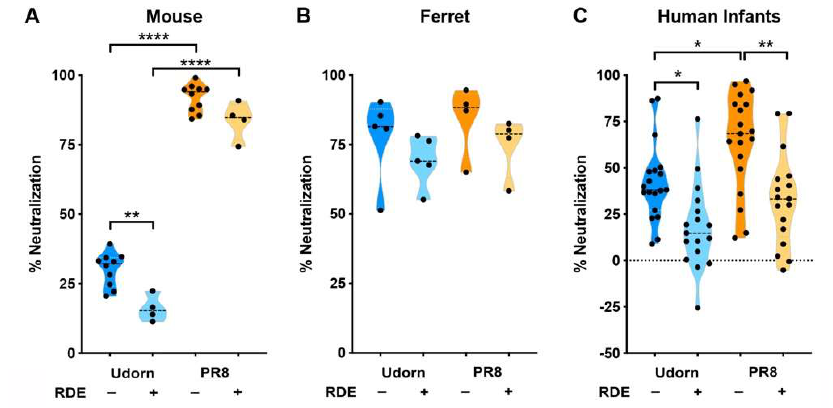
Figure 2. Inhibition of IAV by saliva of different species. PR8 or Udorn virus (5000 PFU) were added to untreated or RDE-treated ( A ) mouse ( B ) ferret or ( C ) human infant saliva at a virus/saliva ratio of 1:9 (vol/vol) for 30 min at 37 °C and the amount of infectious virus recovered was determined by a plaque assay on MDCK cells. The virus recovered in the presence of saliva was expressed as a percentage of that recovered when saliva was mixed with the mock-treated control. Violin plots indicating the mean of each group and probability density of the data at different values are shown. Data are representative of 4–10 independent experiments with pooled mouse saliva or at least three replicate individual saliva samples taken from 4–5 ferrets or 17–19 human infants.